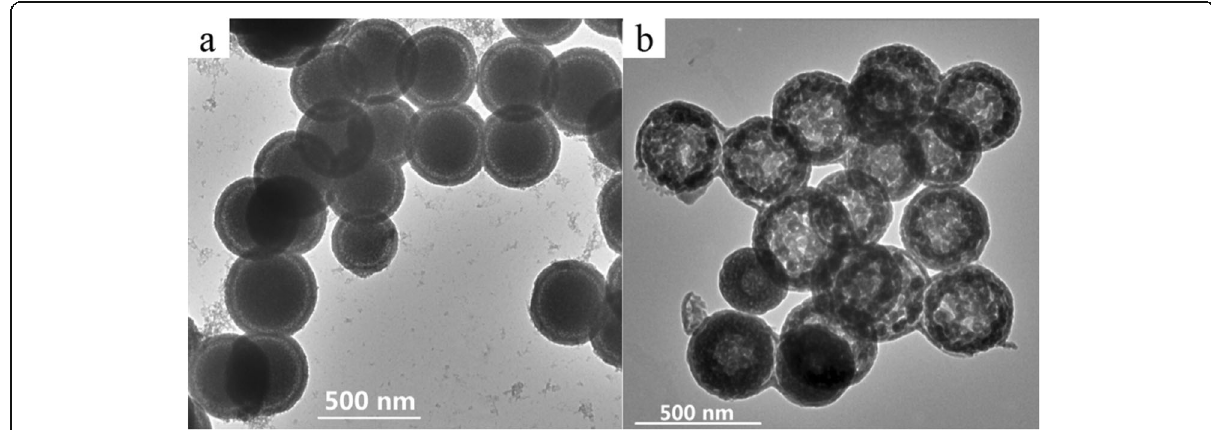
Fig. 1 The TEM characterizations of ( a ) the PDA/silica nanocomposites and ( b ) PPMs q ’ adsorption capacity (mg/g) in differ- t stands for PPMs ent sample time. k 1 and k 2 are the kinetic rates constant. q ecal stands for the equilibrium adsorption capacity cal- culated by model fitting.